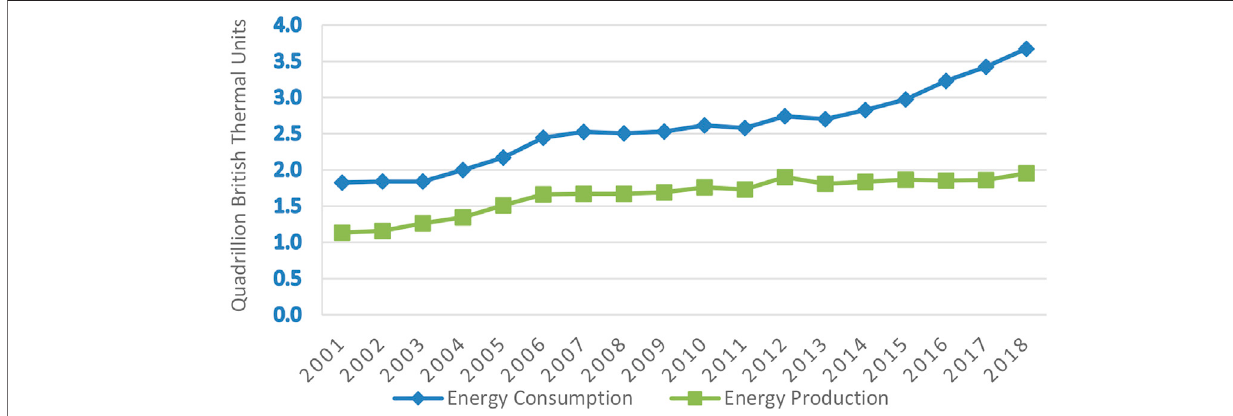
FIGURE 1 | Pakistan ’ s energy production and consumption (2001 – 2018) 1 .